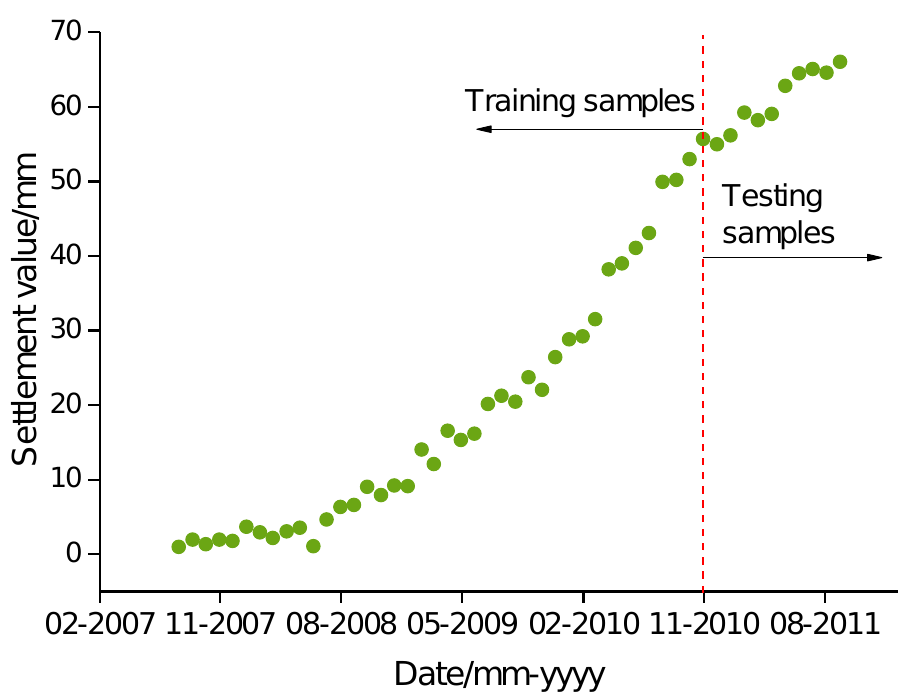
Figure 1. Distribution of the training samples and testing samples from Aug-2007 to Sep-2011.